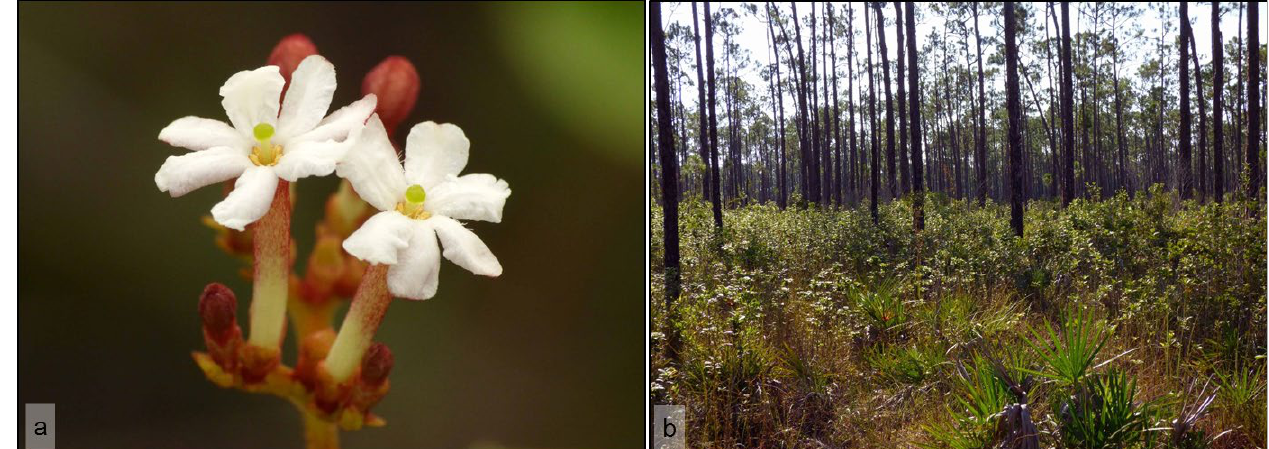
Figure 1. ( a ) Recently opened flowers of Guettarda scabra , during late afternoon. Some individuals, such as the one in this picture, have a long pistil that raises the stigma above the deep corolla tube. Exudates from the stigma were occasionally consumed by visitors such as flies, beetles, and possibly spiders during this study; ( b ) general view of pine rockland habitat at Long Pine Key, Everglades National Park in south Florida, USA. Guettarda scabra plants are abundant in patches scattered among Pinus elliottii trees.